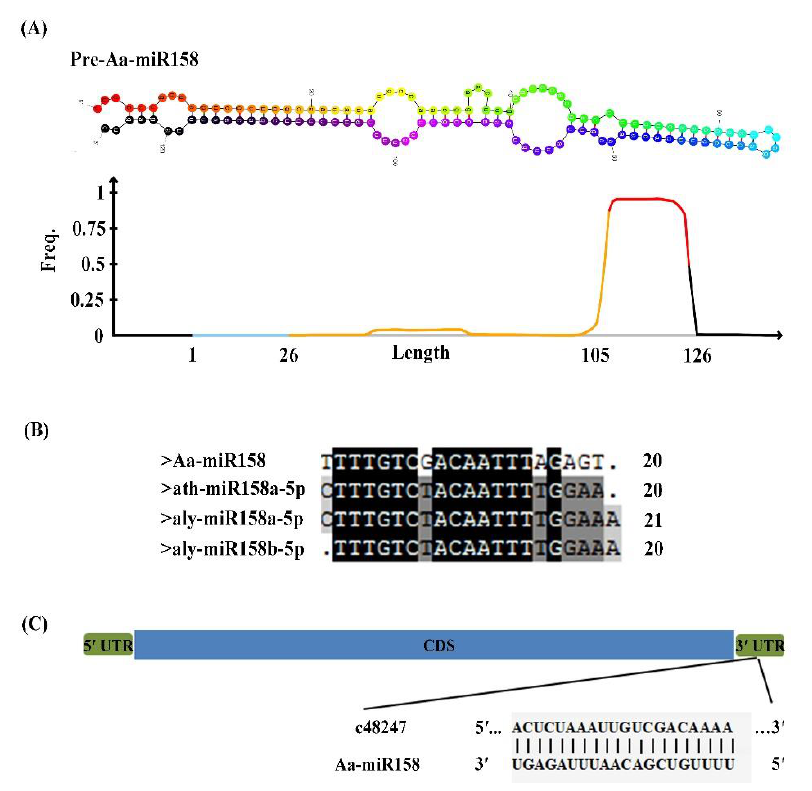
Figure 1. Identification of miR158 from A. andraeanum through small RNA sequencing. ( A ) Predicted stem–loop structure of Aa-miR158. The graph below the diagram shows the distribution of reads on the alignment to the Aa-MIR158 precursor. The red line indicates the mature sequence of Aa-miR158. ( B ) Alignment of miR158 sequences from A. andraeanum (Aa), Arabidopsis lyrata (aly), Arabidopsis thaliana (ath), Brassica napus (Bn) and Brassica rapa ssp. Pekinensis (bra). ( C ) Binding site of Aa-miR158 with its target gene c48247 . The blue rectangle shows the c48247 coding sequence and green rectangles show the 5′ - and 3′ -UTR, respectively.